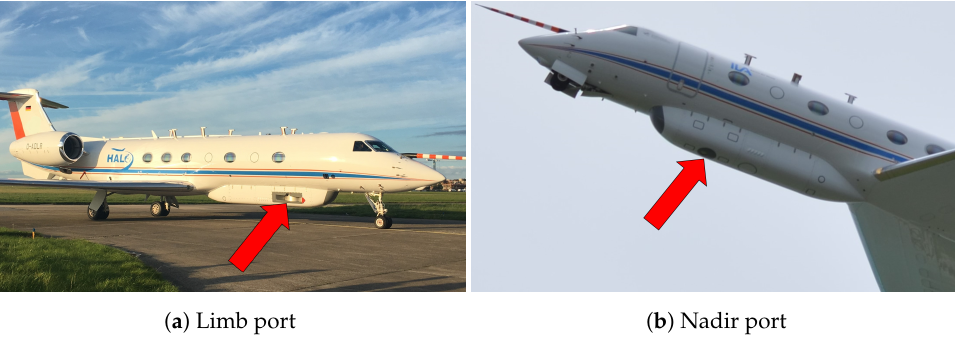
Figure 1. Visual representation of ( a ) the limb and ( b ) nadir port in the belly pod below the HALO aircraft. The ports are indicated by the red